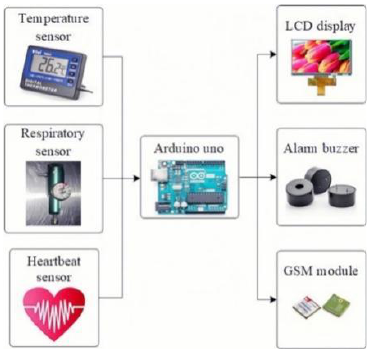
Figure 3. Block diagram of the proposed